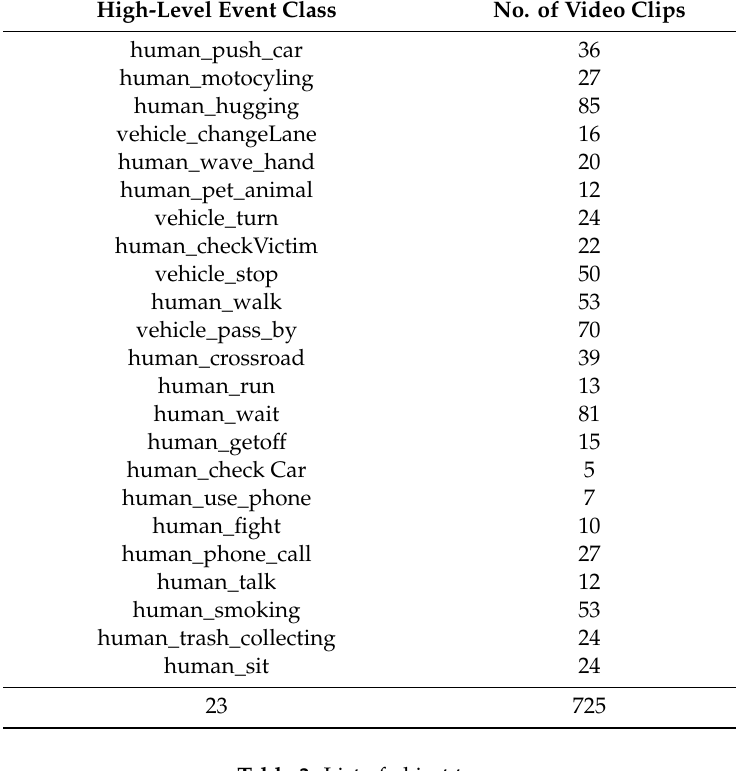
Table 3. List of object types.